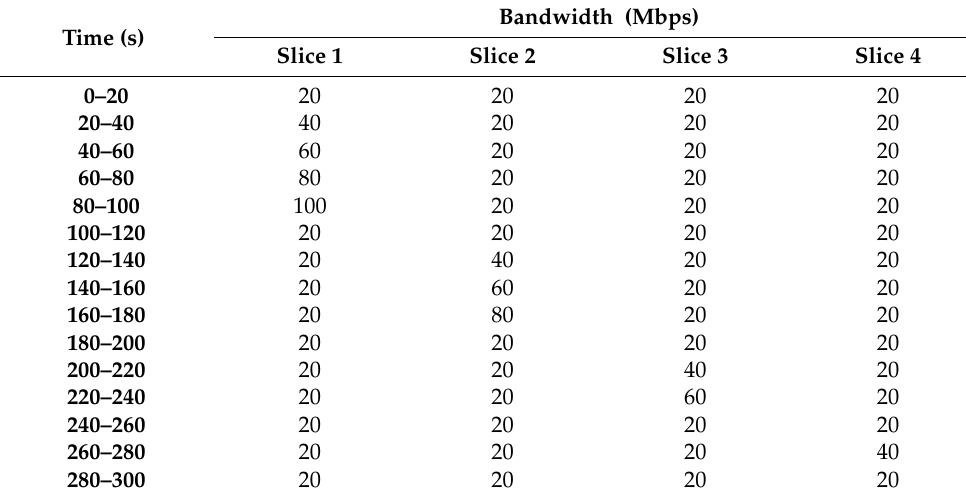
Table 6. Bandwidth transmitted in the saturation